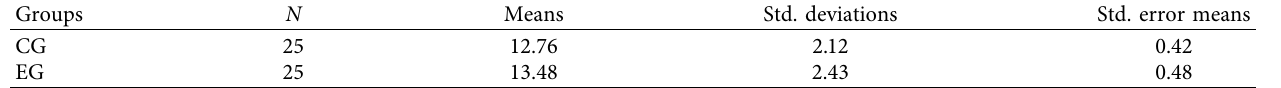
Table 1: Means and standard deviations of both groups on the vocabulary pretest.